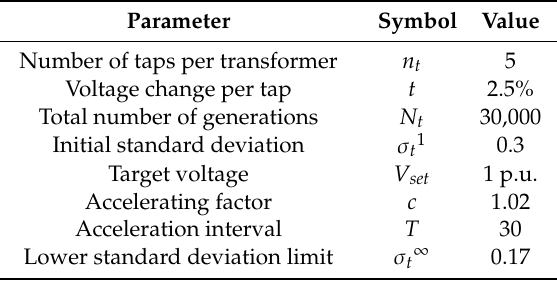
Table 2. Evolution strategy parameters for Case